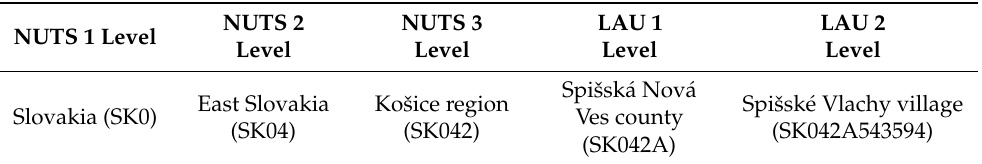
Table 1. Territorial classification according to the territorial systemization of the Slovak Republic as processed at the level NUTS 1-NUTS 3 and LAU 1-LAU